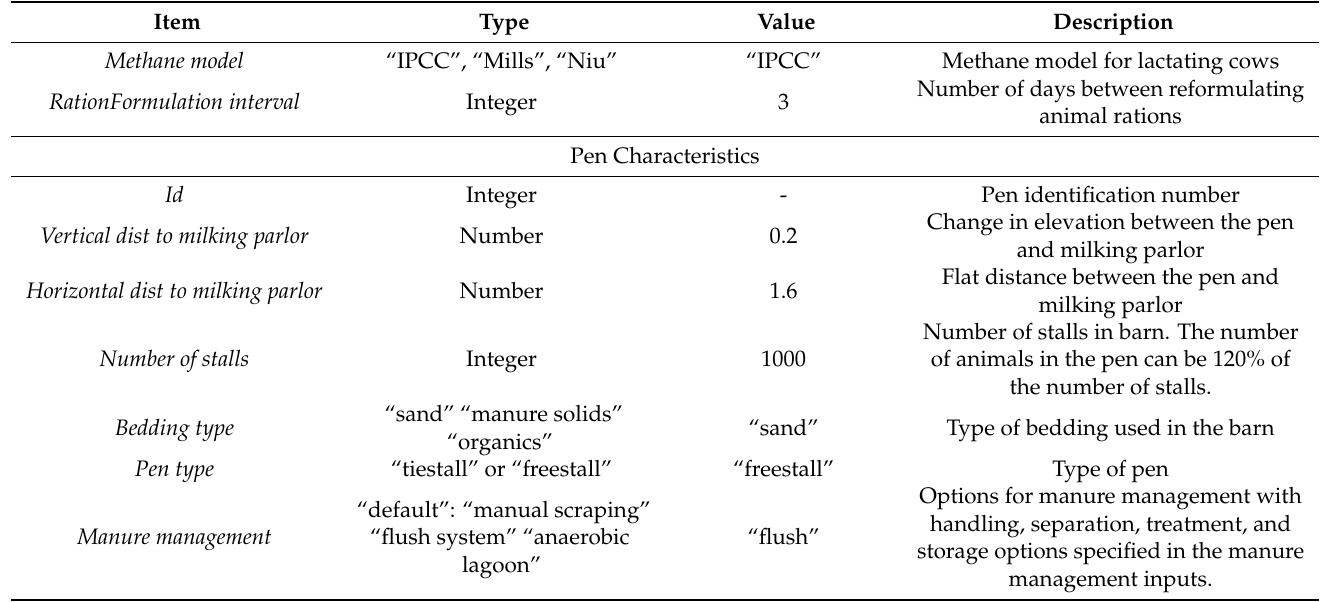
Table A3. User inputs in the Ruminant Farm Systems Model related to pen level